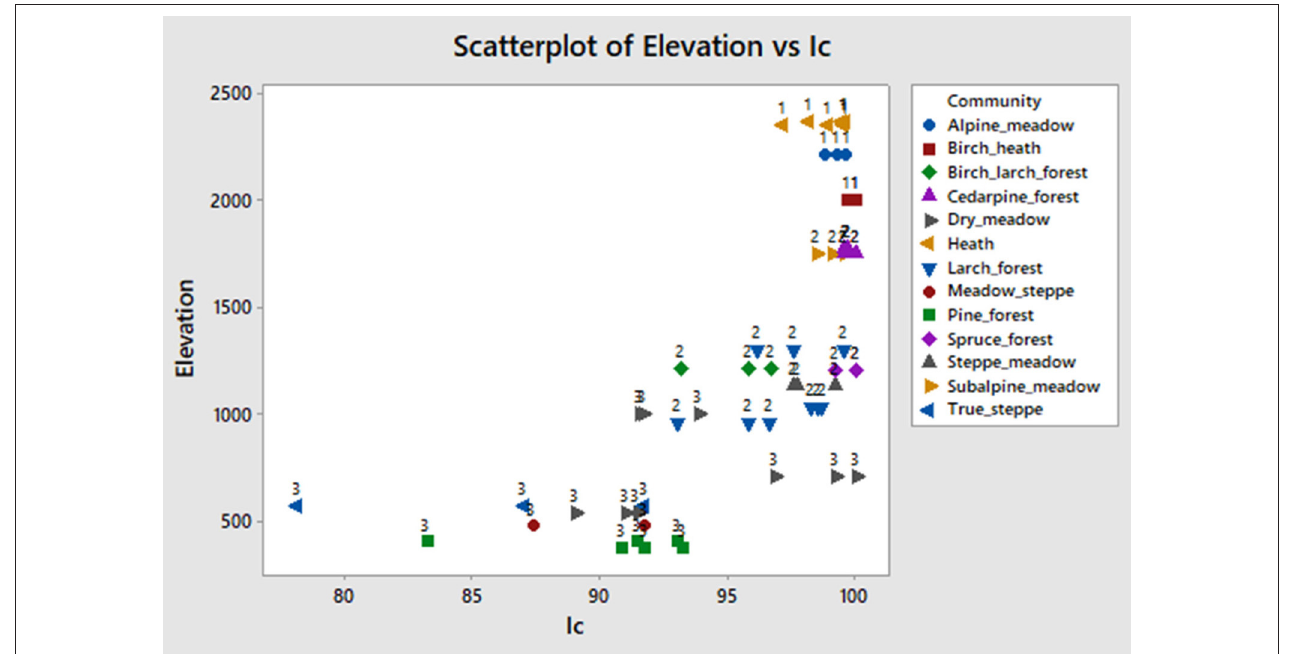
FIGURE 8 | Elevation vs. Ic index scatteplot. The index is explained in text.